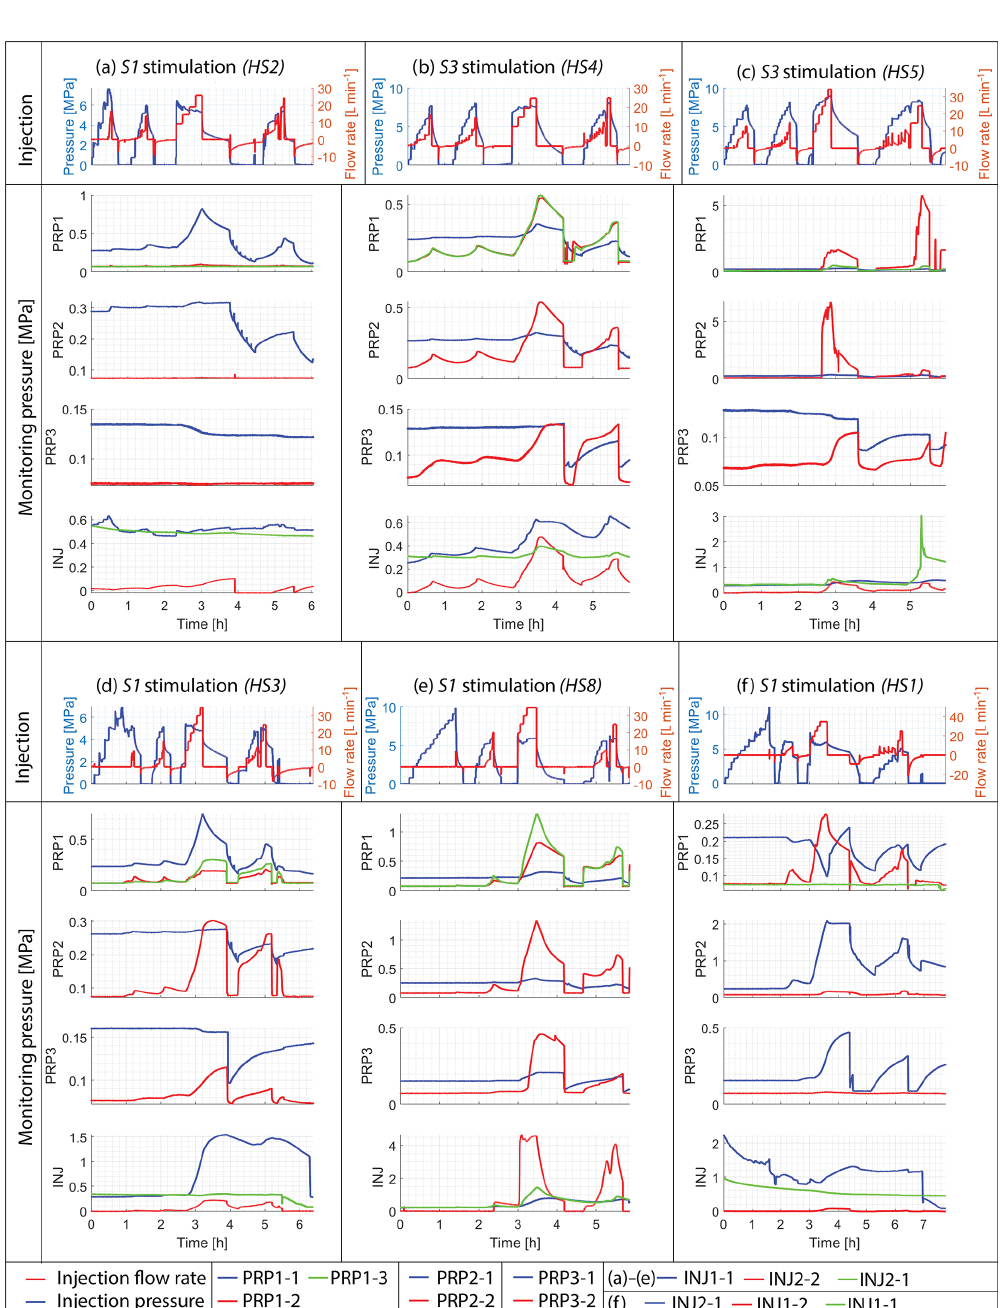
Figure A5. Pressure perturbation time series for all monitoring intervals. The shut-in moments are marked as vertical lines. Note that all intervals were vented after a period of